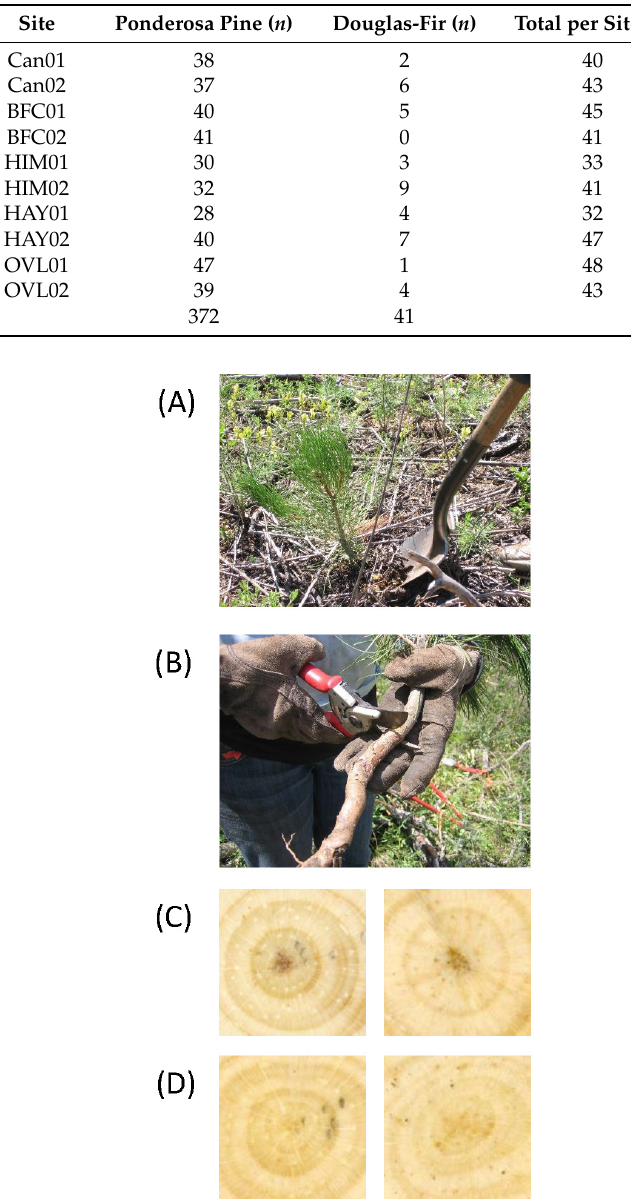
Table 2. Sample sizes of juvenile ponderosa pine and Douglas-fir collected at each site.